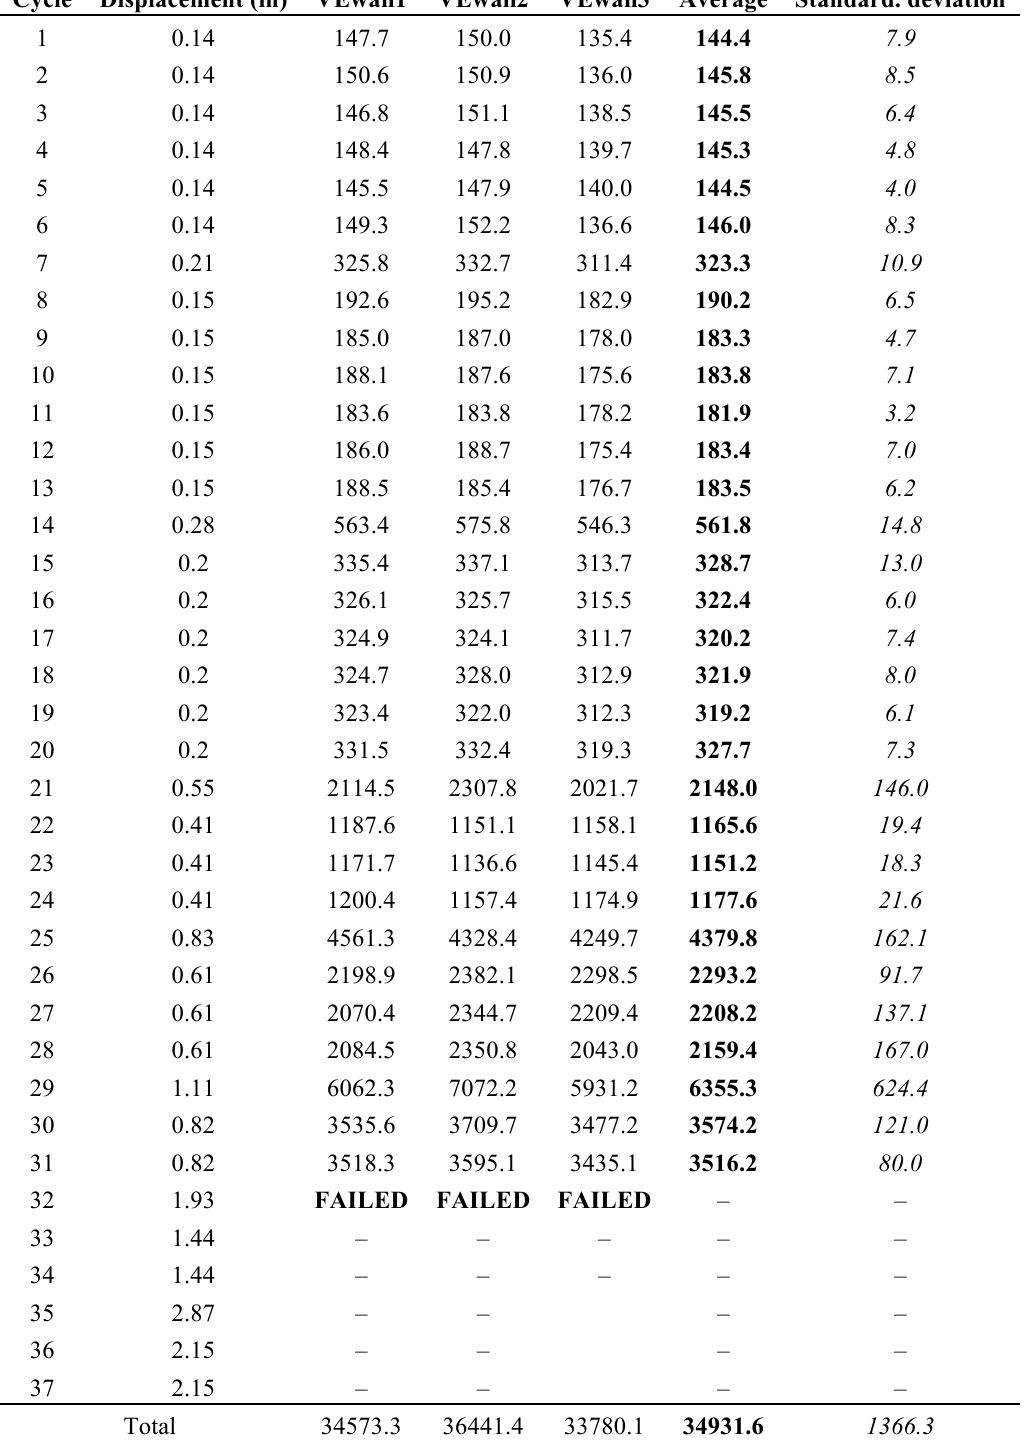
Table 3. Energy Dissipation (lb-in) of